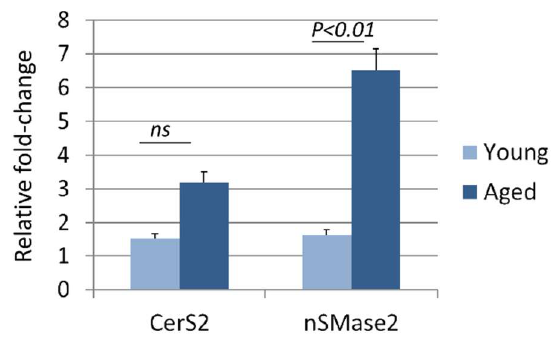
Figure 4. Neutral sphingomyelinase (nSMase2) expression is significantly increased with age in the mouse liver. qPCR results showing the significant increase in nSMase2 expression with age in the mouse liver relative to CerS2 expression ( n = 4 per age group, error bars represent SEM). nSMase2 produces C24:1 ceramide by hydrolysis of sphingomyelin.